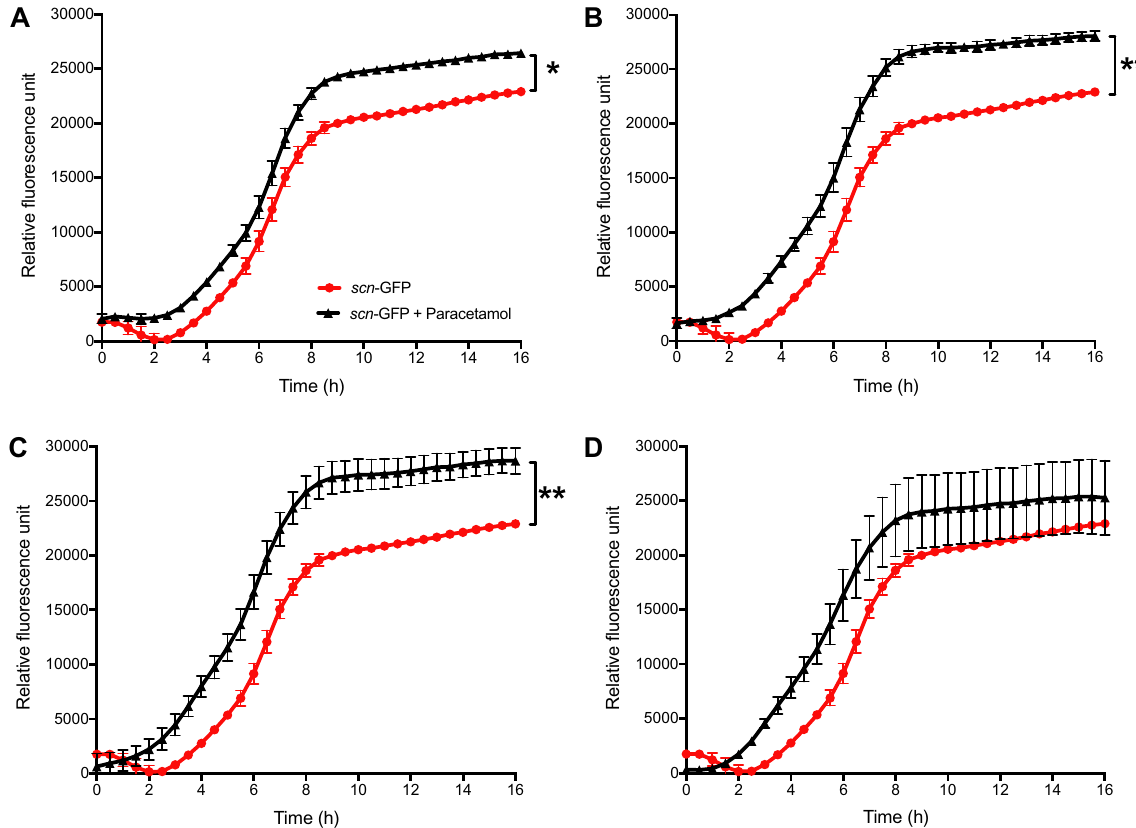
Figure 5. Transcription of the SCIN promoter following paracetamol incubation. Transcription of the SCIN gene promoter—GFP ( scn -GFP +) in strain RN6390 (CC8) was monitored during overnight incubation at 37 °C without and with 0.5 ( A ), 1 ( B ), 2 ( C ) or 4 ( D ) μg/mL of paracetamol. A single asterisk (p < 0.05) and two asterisks (p < 0.01) represent a statistically significant difference between without and with paracetamol treatment. Data from three separate experiments are presented as mean value and